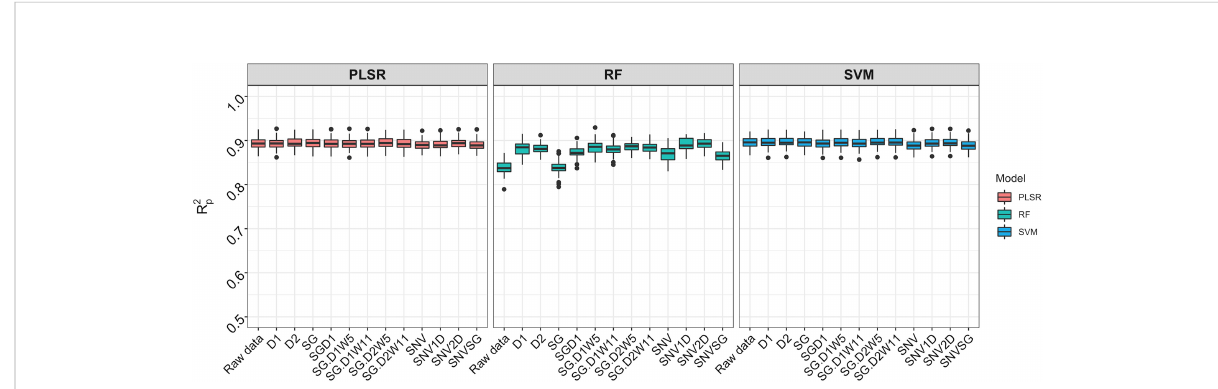
FIGURE 4 Comparisonof three chemometric modeling approaches using SCiO spectral data and allaccessions combined. Pearson ’ s correlationbetween predicted and observed values in the test set is represented by the y-axis (R 2 p ). The various pretreatment approaches and the model without spectral pretreatment (raw data) aredepicted onthe x-axis (standardnormal variate (SNV),standardnormal variate and fi rst derivative (SNV1D), standardnormal variate and second derivative (SNV2D), fi rst derivative (D1), second derivative (D2), Savitzky-Golay with window size = 11(SG), standardnormal variate and Savitzky-Golay (SNVSG), gap segment derivative with window size = 11 (SGD1), Savitzky-Golay with window size= 5 and fi rst derivative (SG.D1W5), Savitzky-Golay with window size = 11 and fi rst derivative (SG.D1W11), Savitzky-Golay with window size= 5 and second derivative (SG.D2W5), and Savitzky-Golay with window size = 11 and second derivative (SG.D2W11)). Three modelingapproaches wereevaluated: random forest (RF), partial least squareregression(PLSR), and support vector machine (SVM) (SVM).SVM and PLSR both produced consistent